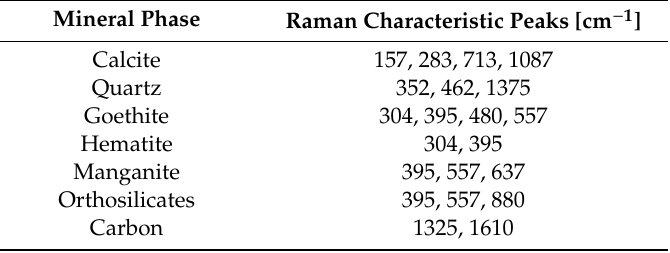
Table 4. The tentative assignment of the observed Raman lines to the di ff erent mineral phases of the mosaics fragments.